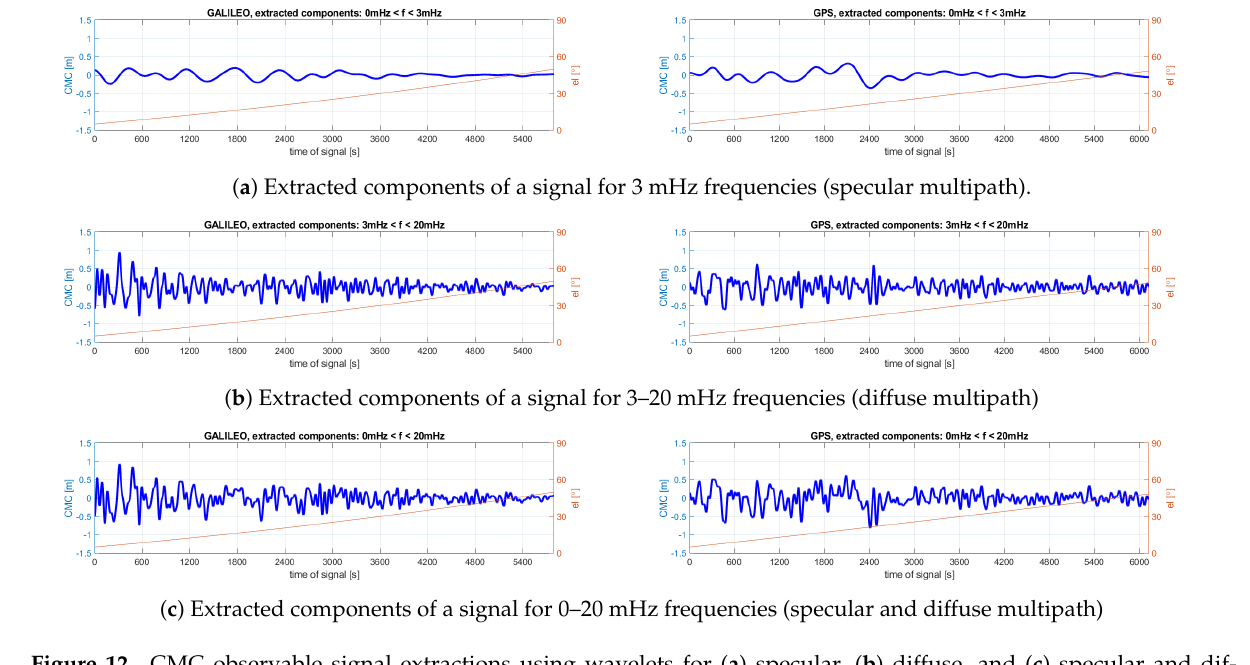
Figure 12. CMC observable signal extractions using wavelets for ( a ) specular, ( b ) diffuse, and ( c ) specular and dif- fuse multipaths.